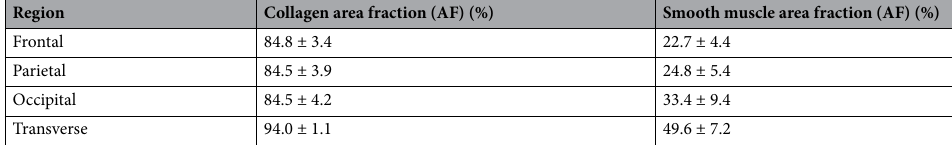
Table 2. Collagen area fraction (AF) values and smooth muscle area fraction (AF) values for the various regions of the dural venous sinuses. Data are represented as a mean ± standard error about the